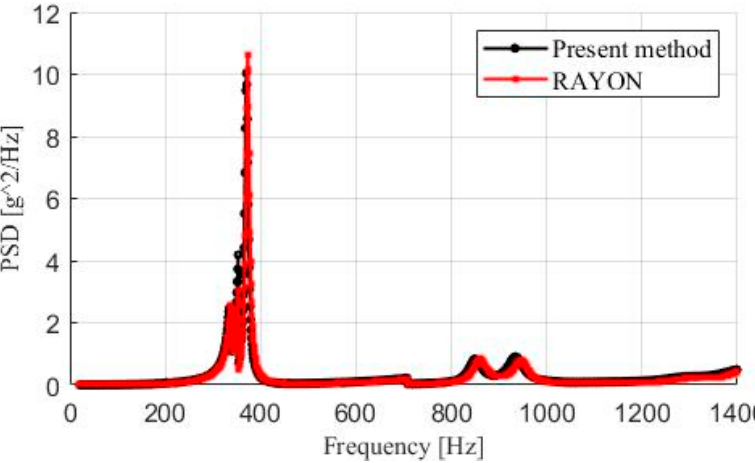
Figure 14. Power spectral density at node P3X (0.6,0.208) for a rectangular plate immersed in a diffuse field.